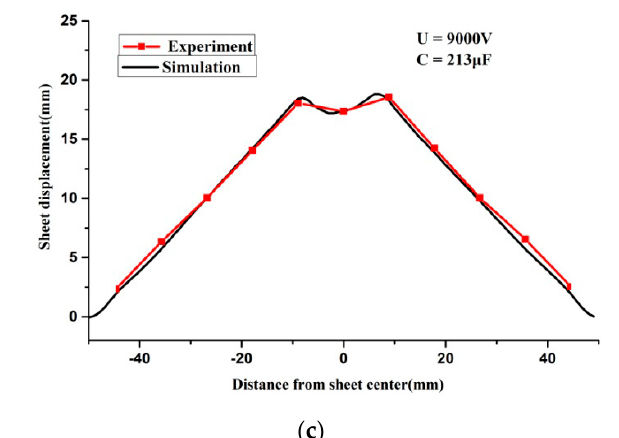
Figure 16. The deformation height and shape profiles of high-speed impaction at a discharge voltage of 9 kV: ( a ) experimental result; ( b ) simulation result; and ( c ) profiles comparison between the experimental and simulated results along central plane.